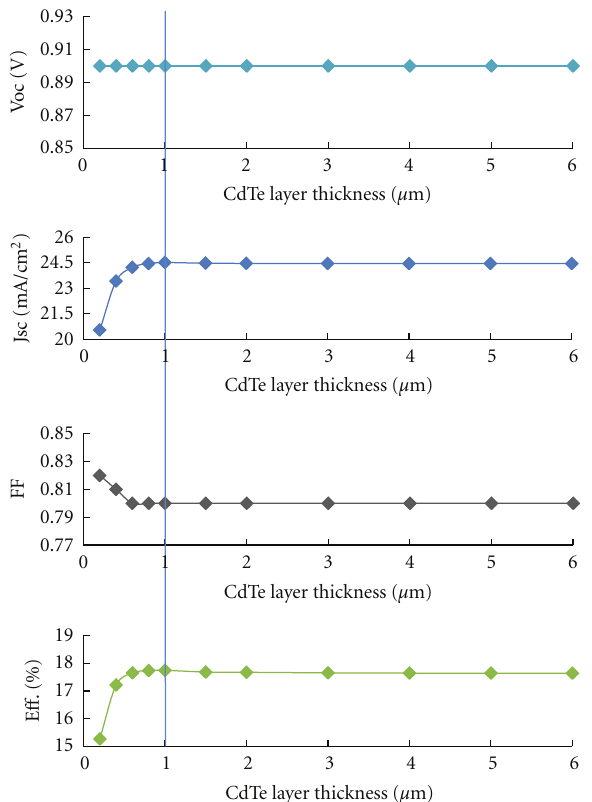
Figure 2: E ff ect of CdTe film thickness on cell parameters.